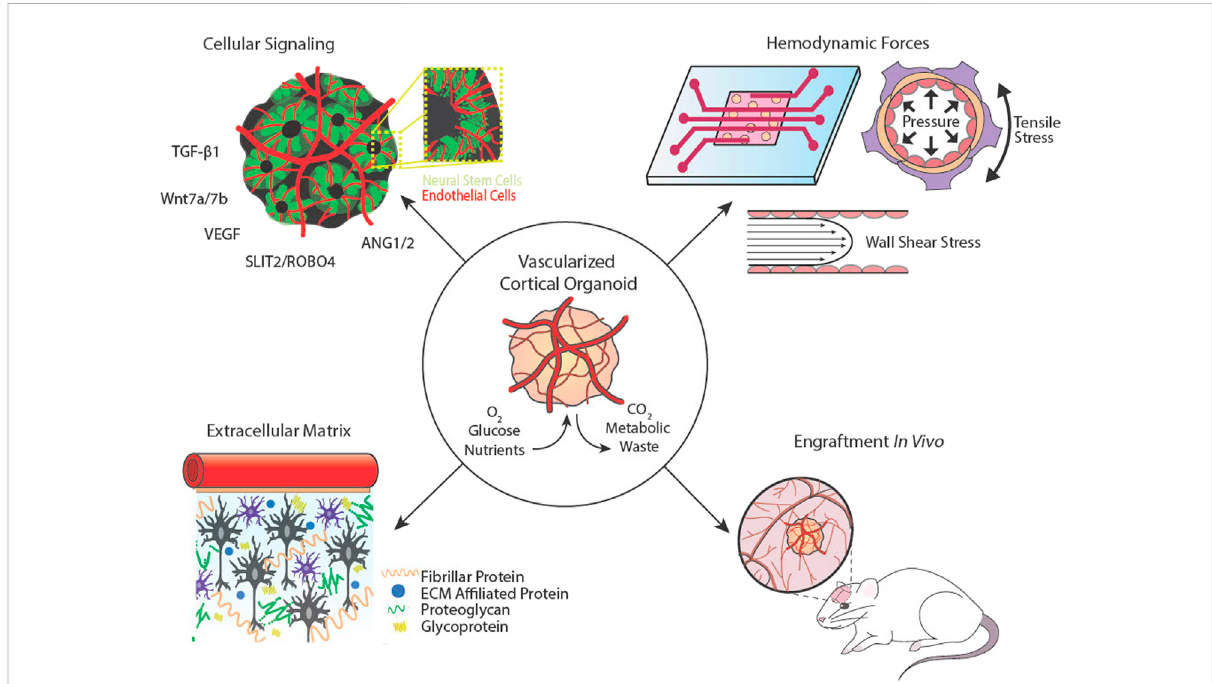
FIGURE 2 Corticalorganoidvascularizationcomponentsandconsiderations.Cellularsignallingbetweenneuralandvascularcellsisessentialforcomplex network architecture. Hemodynamic forces that exude pressure and shear stresses on vessel walls can be mimicked using micro fl uidics. The extracellularmatrixprovidessupportandaidsinmechanotransduction.Corticalorganoidsmaybeimplantedintoanimalhoststoconnectwithorbe invaded by host